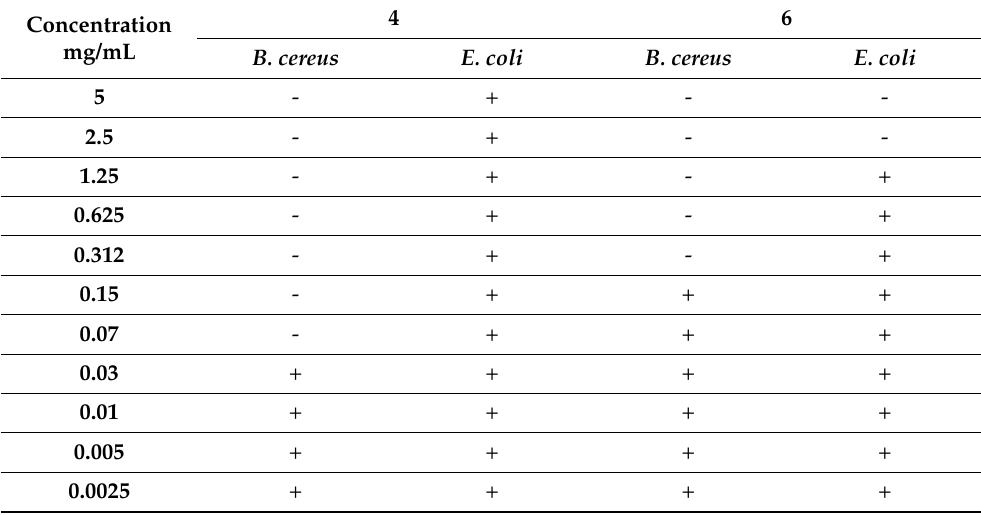
Table 5. In vitro antibacterial activity of imidazo[4,5-b]pyridine derivatives ( 4 and 6 ).